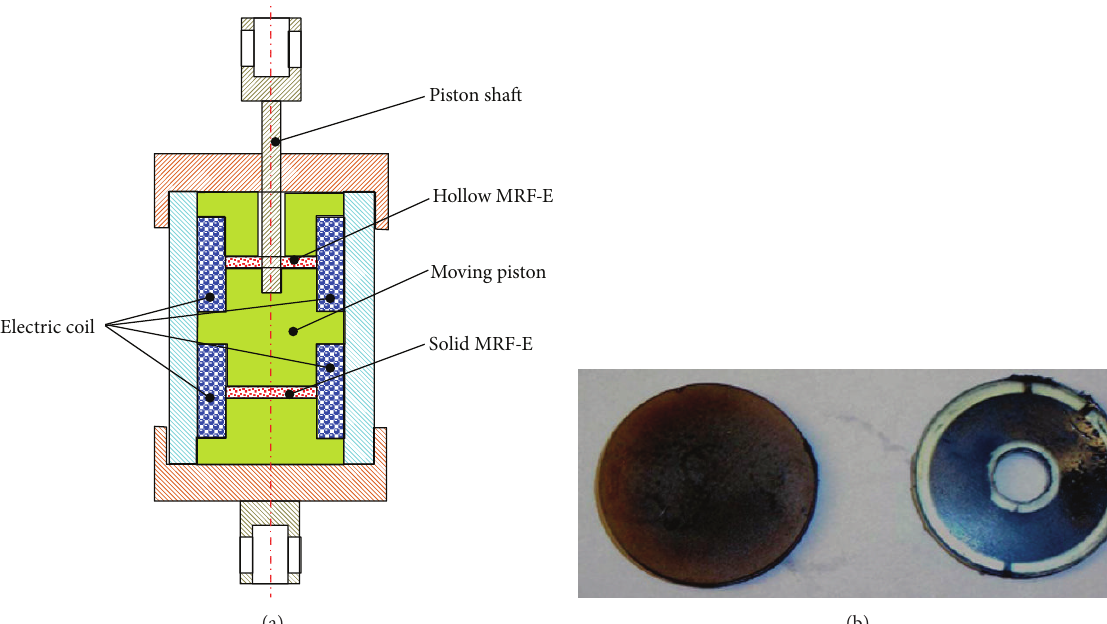
Figure 11: (a) Configuration of MR elastomer mount and (b) photograph of MR elastomer plate.